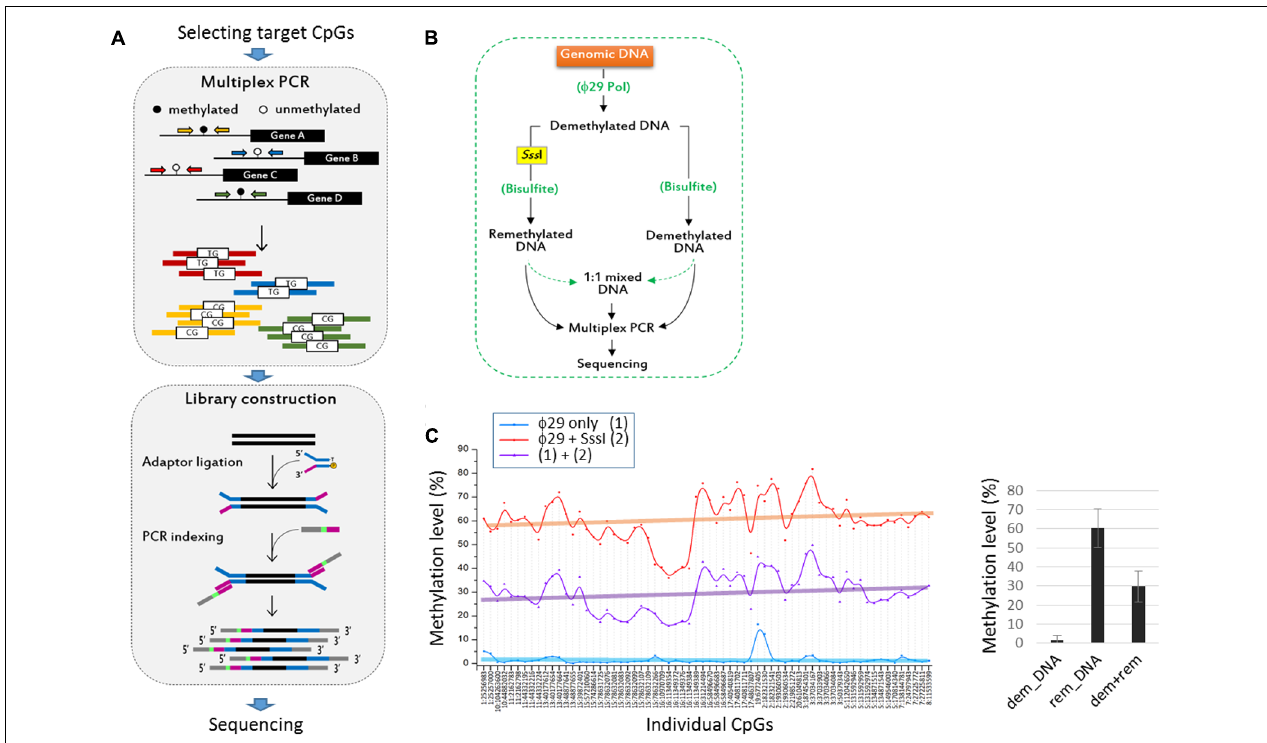
FIGURE 1 | Evaluation of the targeted bisulfite PCR sequencing (TBPseq) method. (A) Illustration of TBPseq method. Colored horizontal arrows denote primers for target amplification. Amplicons have methylated (5 (cid:48) -CG-3 (cid:48) ) or unmethylated (5 (cid:48) -TG-3 (cid:48) ) sequences for target CpGs, the ratio of which is used for calculating methylation frequencies of the target CpGs. A total of 113 primer pairs were split into six groups of about 20 pairs for separate multiplexed PCR. (B) Strategy for evaluating the TBPseq method. The whole genomic DNA of 293T cells was amplified using φ 29 DNA polymerase. A half of the resulting newly synthesized and unmodified (demethylated) DNA was re-methylated in vitro using CpG dinucleotide-specific Sss I methylase. The remethylated and demethylated DNA fractions were equally treated with bisulfite and used as template in multiplex PCR with 20–25 primer pairs per reaction. Multiplex PCR was additionally performed with an equal mixture (1:1 mixed DNA) of the remethylated and demethylated DNA templates. The three different groups of amplicons were modified and differentially barcoded for Illumina sequencing. (C) Methylation levels of target CpG sites. Each CpG site has three different methylation levels that were obtained from demethylated DNA ( φ 29 only, blue), remethylated DNA ( φ 29 + SssI, red), and an equal mixture of them (purple). In the right panel, the mean methylation levels of target CPGs in the three DNA groups are shown (error bars, standard deviation). Individual CpG sites are indicated by their genomic position as “chromosome (chr) number:coordinate” using GRCh37/hg19 as reference